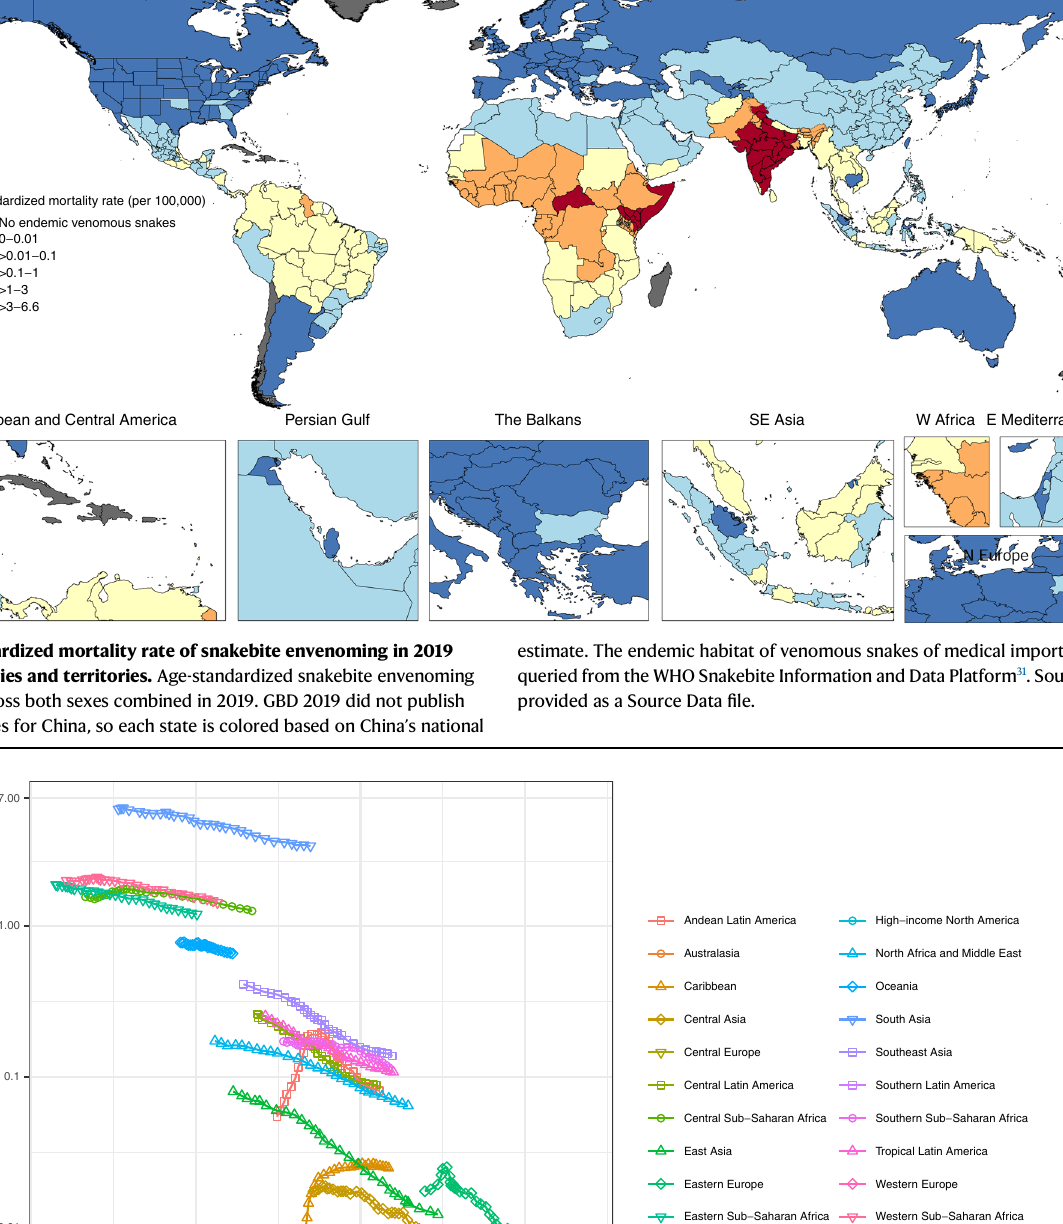
Socio-demographicIndex. Eachpointrepresents the age-standardized mortalityin a givenyear from 1990 to 2019intheregion. Y-axis ison log scale.Source data are provided as a Source Data fi